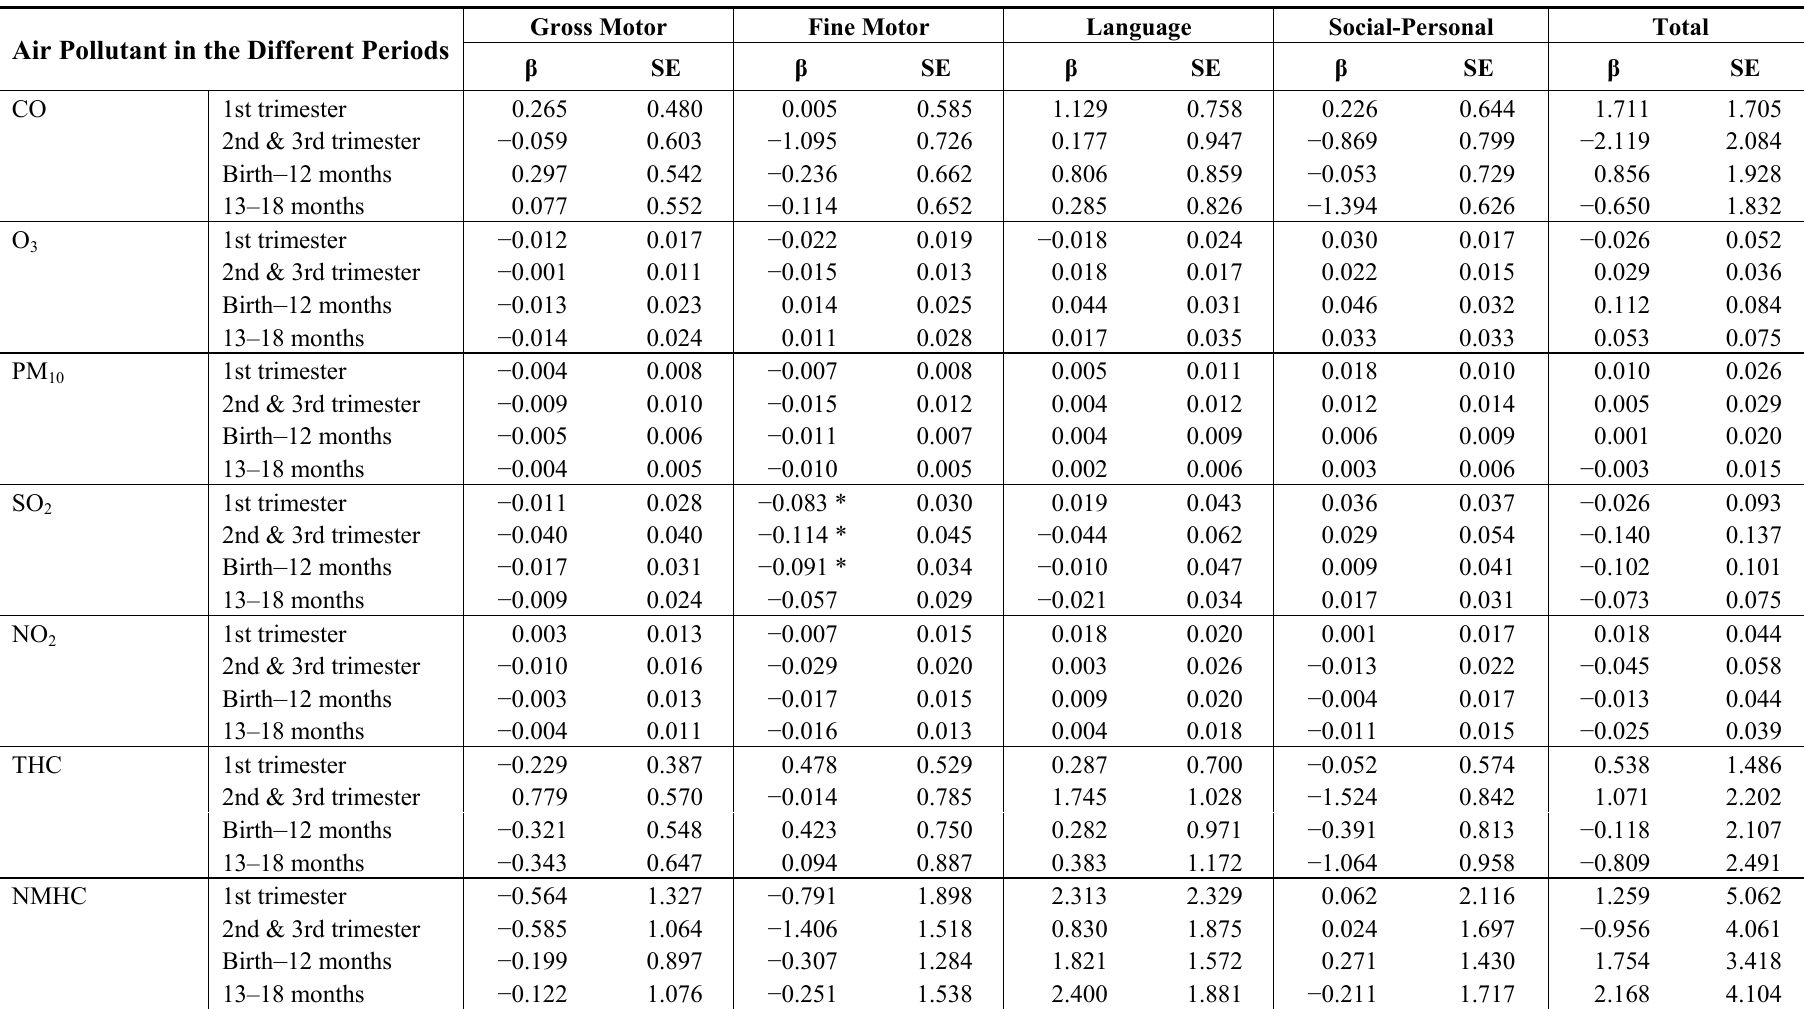
Table 4. Multilevel analysis of single air pollutants and neurodevelopment scores at eighteen months of